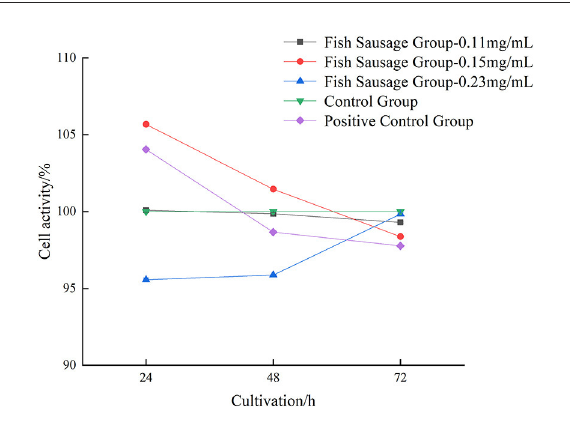
FIGURE1 The impact of in vitro digestive juice of bass on the viability of Caco-2 cells.